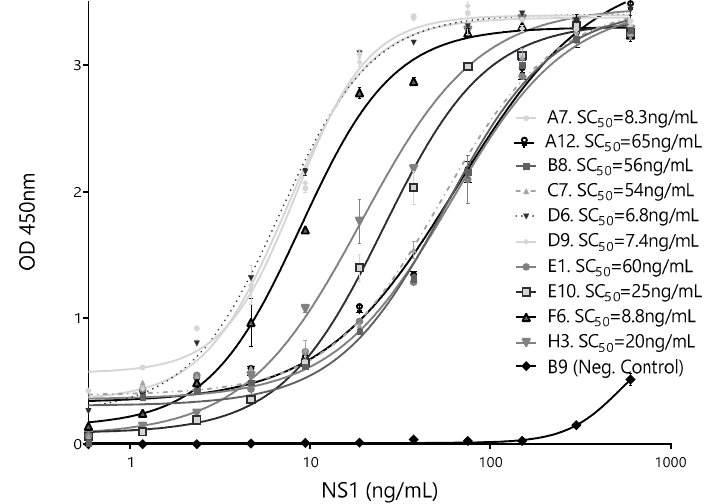
Figure 7. Calibration curves of the best-performing pairs. The sandwich ELISA was performed using BtNb32 as the capture antibody in combination with ten detection clones. The NbB9 with specificity for human hemoglobin was used as a negative control. The concentration corresponding to 50% of the maximum readout, SC 50 (ng / mL), for each di ff erent pair is shown. Measurements were done by triplicates.